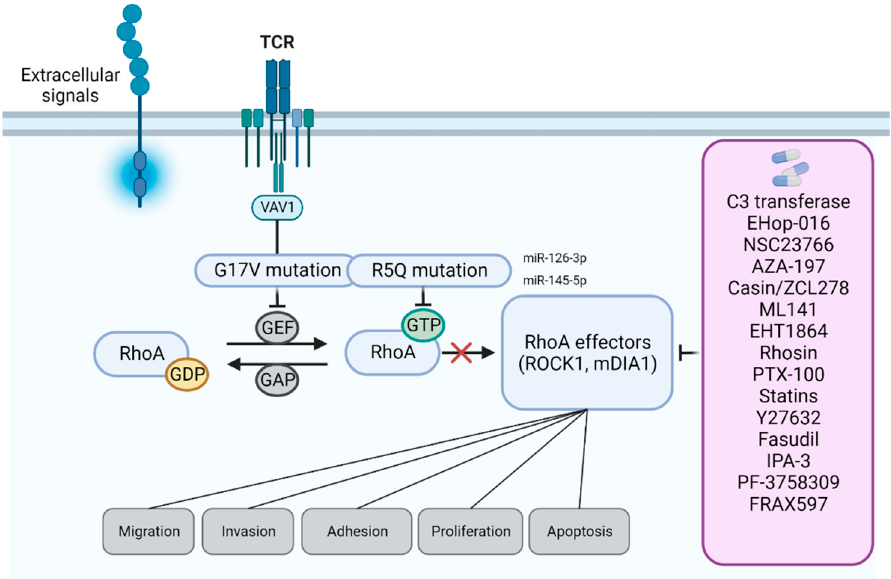
Figure 2. RhoA alterations and therapeutic targeting RhoA-associated signaling in hematological cancers.